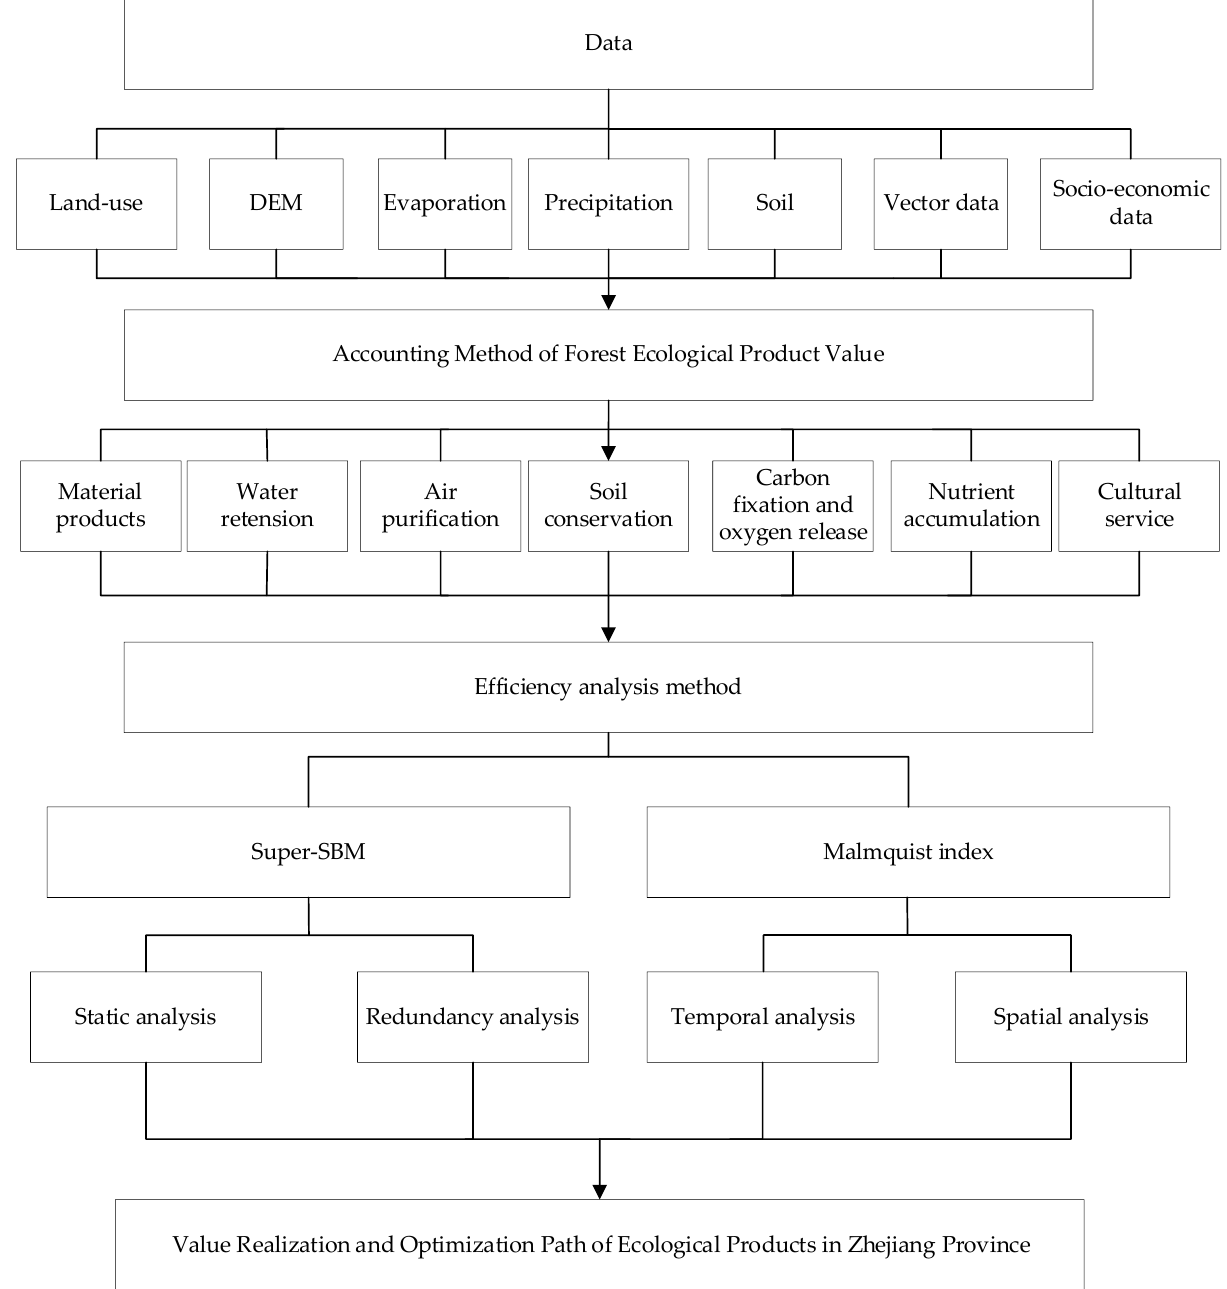
Figure 2. The technology roadmap.